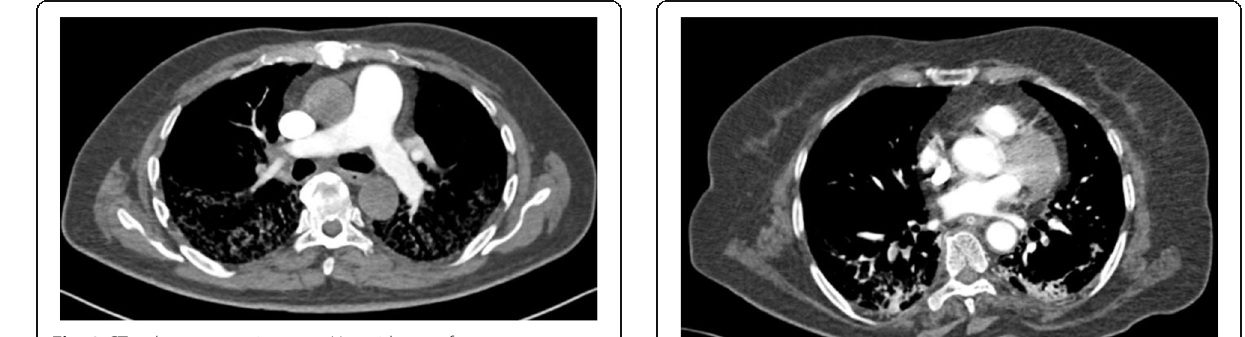
Fig. 3 CT pulmonary angiogram - No evidence of pulmonary embolism